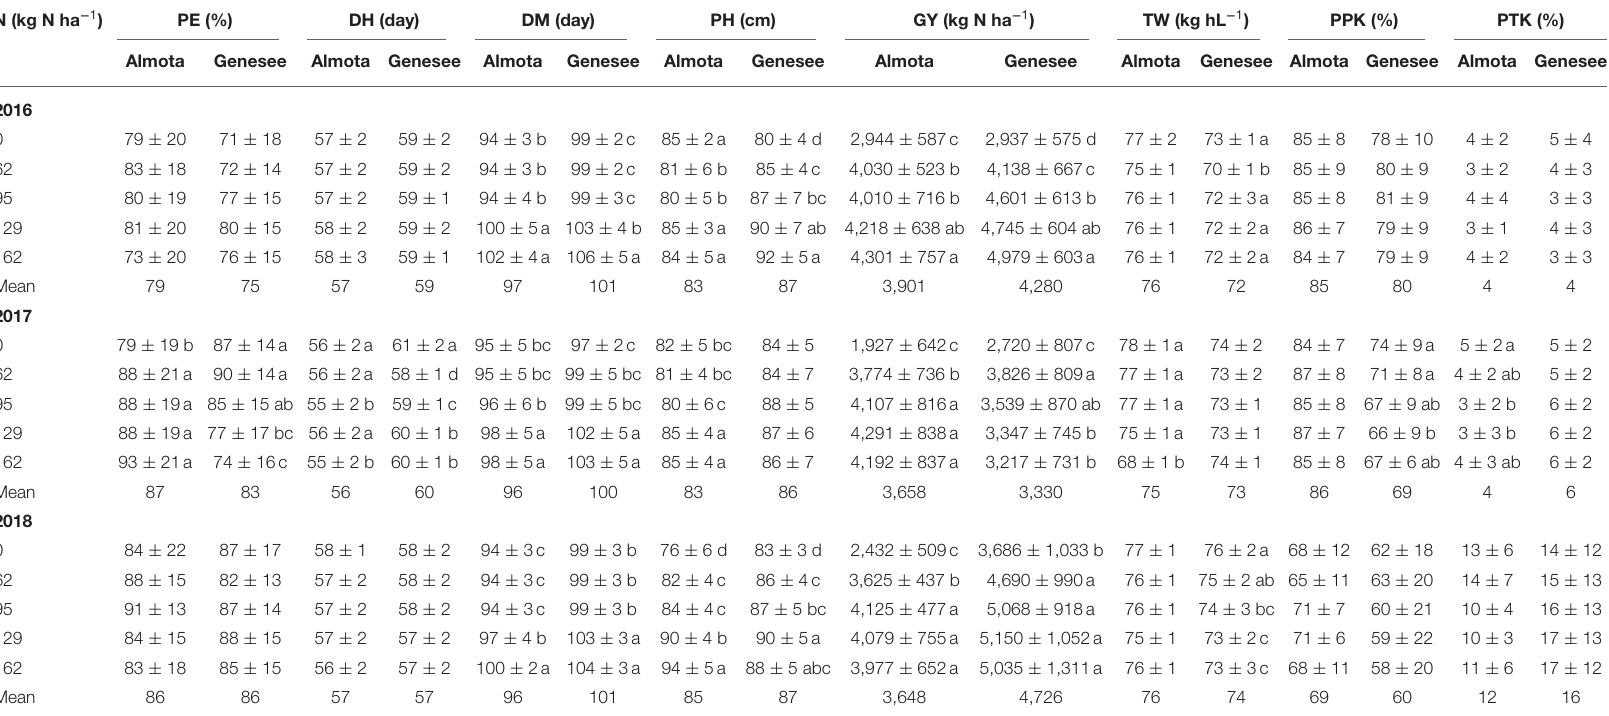
TABLE 5 | Mean data across six site-years for nitroge N rates on agronomic